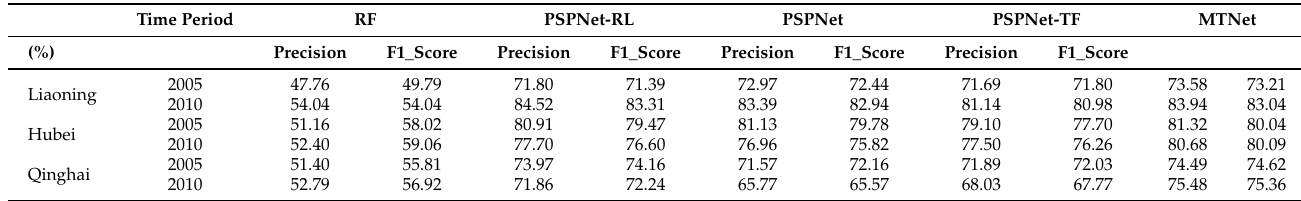
Table 4. Precision and F1_score for the study areas (Liaoning, Hubei and Qinghai provinces).